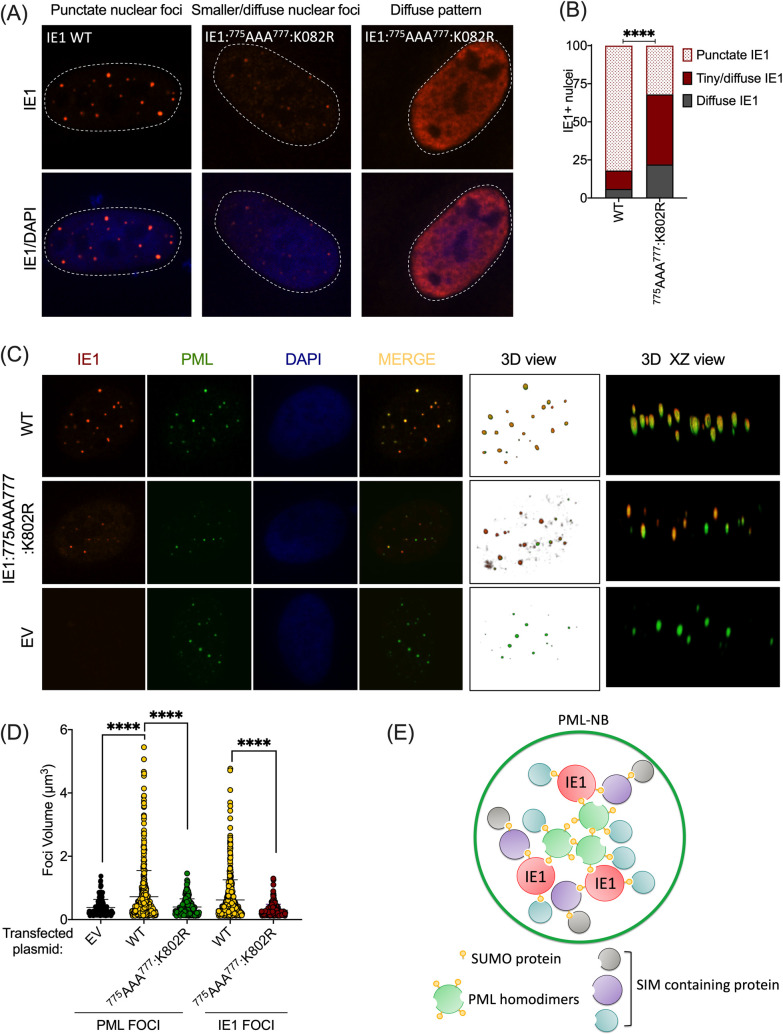
MultiSUMOylated IE1 contributes to nuclear bodies accumulation.(A) Confocal microscopy showing IF images of patterns of IE1 in U2OS transfected with WT IE1 and 775AAA777:K802R mutant. (B) Graph showing the quantification of pattern in U2OS between WT IE1 (n = 85) and 775AAA777:K802R mutant (n = 32). Total IE1+ nuclei were counted and divided in three categories: punctate, tiny dots/diffuse and totally diffuse patterns. Data were normalized on 100. ****P<0.0001, chi-square. (C) Deconvoluted IF of IE1 WT and 775AAA777:K802R mutant, 48 hours post-transfection. (D) Graph representing the volume of each PML and IE1 foci per nucleus with EV (n = 24) WT IE1 (n = 45) and 775AAA777:K802R mutant (n = 20) ****P<0.0001, chi-square. (E) Hypothesis of interacting network of IE1 following multiSUMOylation by PML. MultiSUMOylation of IE1 in PML-NBs allow the recruitment of SIM-containing interacting partners at the additional SUMOylated site of IE1, resulting in bigger nuclear bodies.